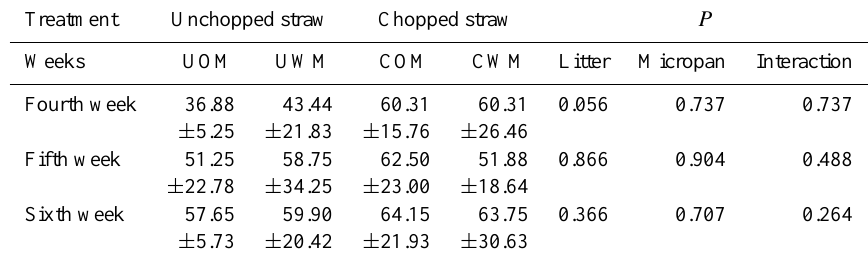
Table 2. Effect of straw size and litter amendment (Micropan) on ammonia concentration (NH 3 , ppm) in the fourth, fifth, and sixth week of age ( ¯ x ±